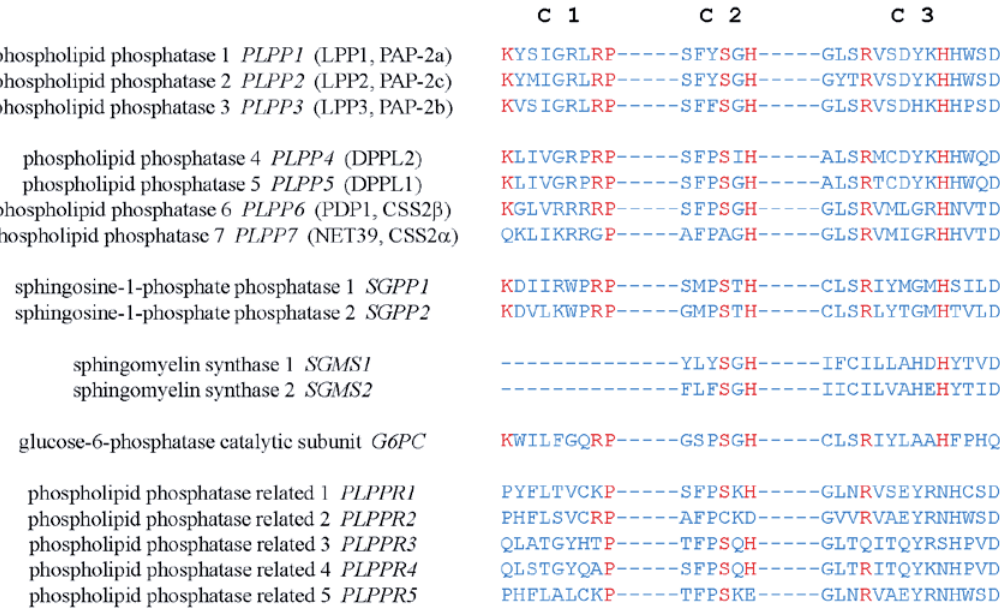
Figure 1. The membrane topology of lipid phosphate phosphatases (LPPs). Six membrane-spanning regions (1–6) are connected with five extramembrane loops (I–V). Three conserved catalytic domains, C1, C2, and C3, are located on loops III and V. The N-linked glycosylation site on the loop III is shown as a blue square.